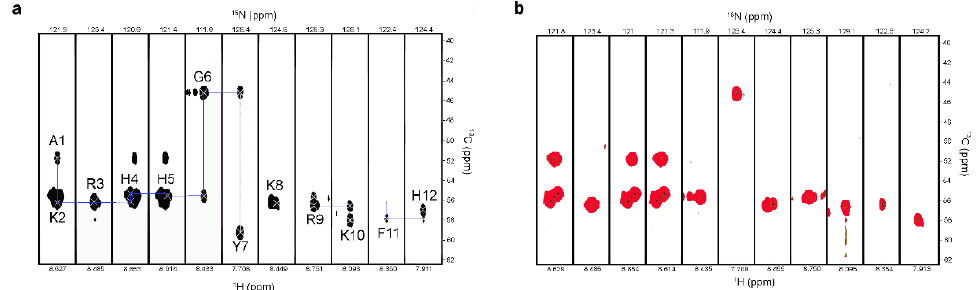
Figure 2. Strip plots representative of three-dimensional, amide-detected heteronuclear NMR spectra for backbone assignment. Inter- and intraresidual correlations of P-113 residues were obtained from correlating ( a ) an HNCA spectrum to ( b ) an HN(CO)CA spectrum. The blue line indicates the sequential walk. A segment of P-113 after degradation by C. albicans at 301 K is shown, depicting lost connectivity between the pairs of residues Y7-K8, K8-R9, and K10-F11.